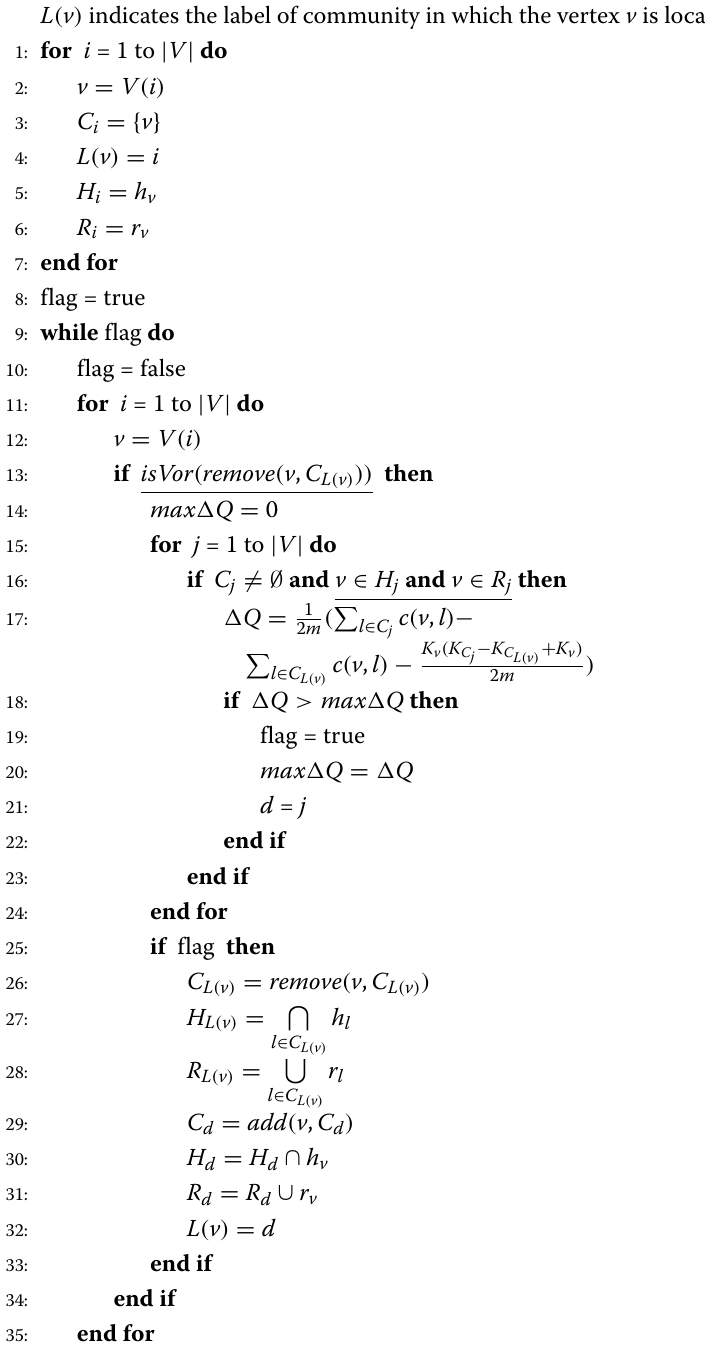
Algorithm 1 Community Clique Detection